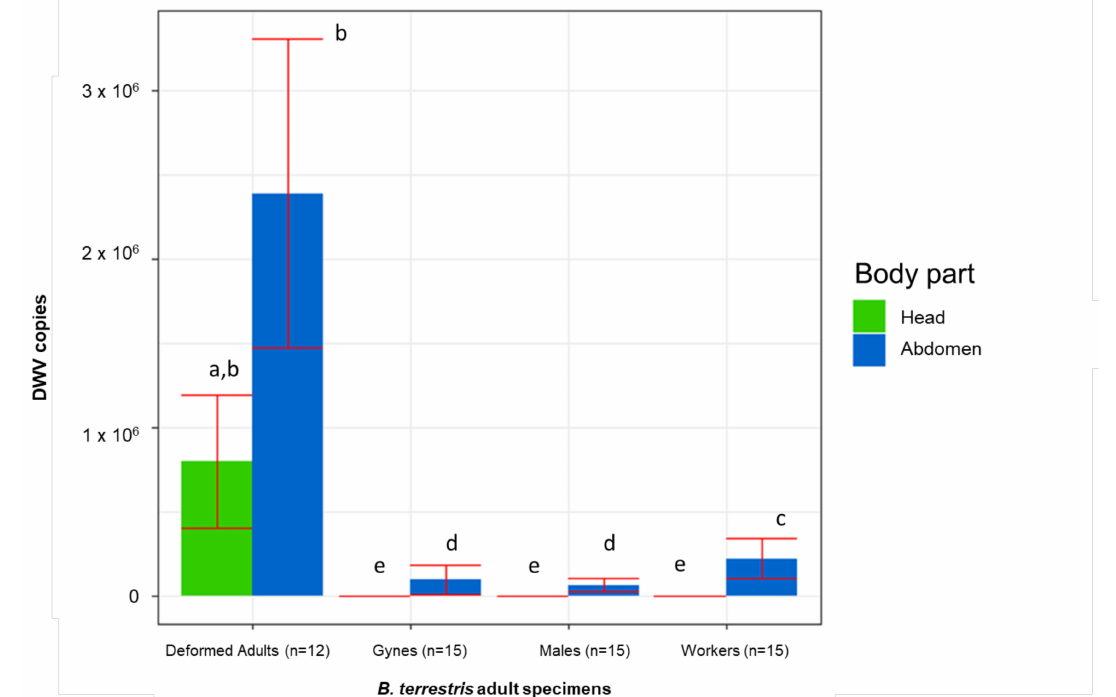
Figure 4. DWV copies detected in both head and rest of the body of deformed and asymptomatic B. terrestris adults. Averages (columns) and standard errors (vertical bars) are shown. The same letters highlight nonsignificant differences ( p ≤